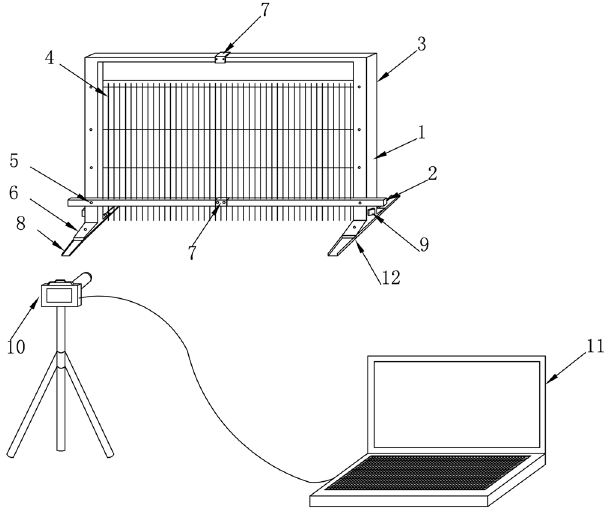
Figure 7. Scheme of the designed pin meter. Notes: 1. Support 2. Cross bar 3. Pin meter plate 4. Pin meter 5. Adjustment nut 6. Base 7. Widget 8. Level track 9. Micro motor 10. Camera 11. Output device 12. Extending parts. The figure was made by AutoCAD 2014